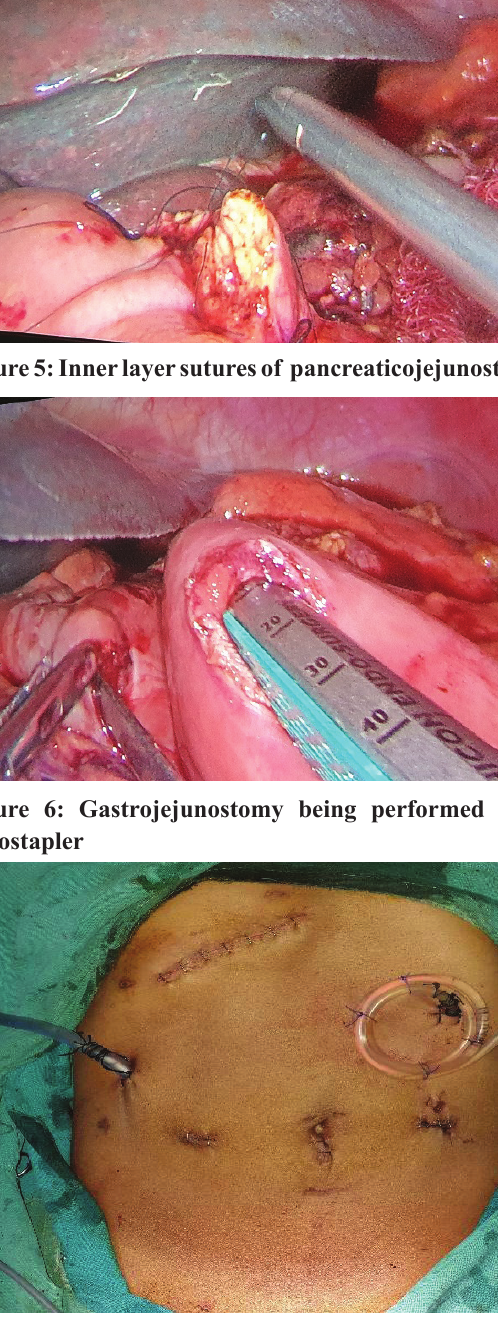
Figure 7: Post operative